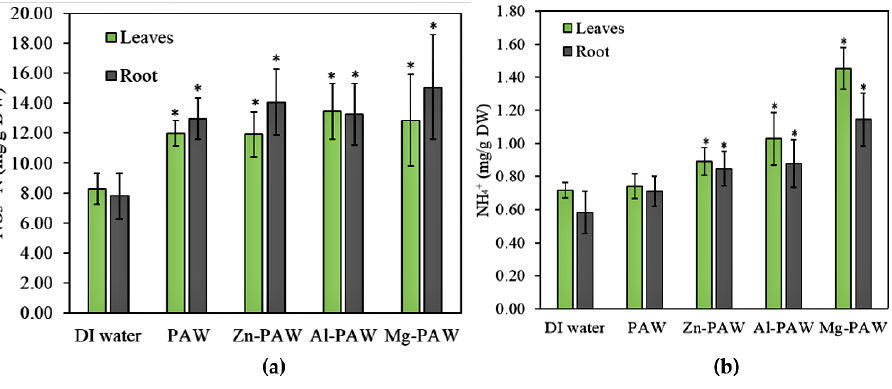
Figure 8. ( a ) NO 3 -N ( b ) NH 3 or NH + present in the root and shoot tissues of dry corn plants after 4 the 10th day of soaking in DI water, PAW, PAW with Zn (Zn-PAW), PAW with Al (Al-PAW), or PAW with Mg (Mg-PAW). The symbol ∗ is for t-test result above the 5% significance